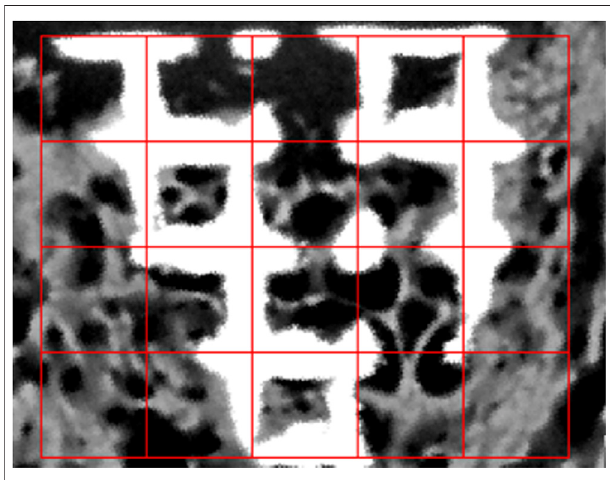
FIGURE 3 | MATLAB program image analysis of